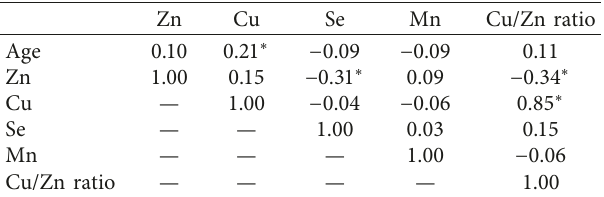
Statistically significant correlation at 0.05 significance level.